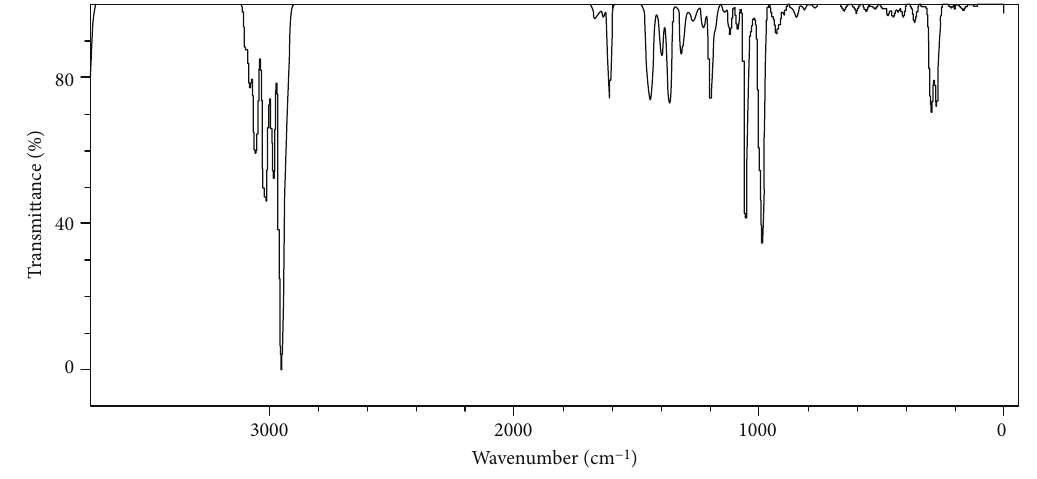
Figure 6: Theoretical ZEA-MeOH IR